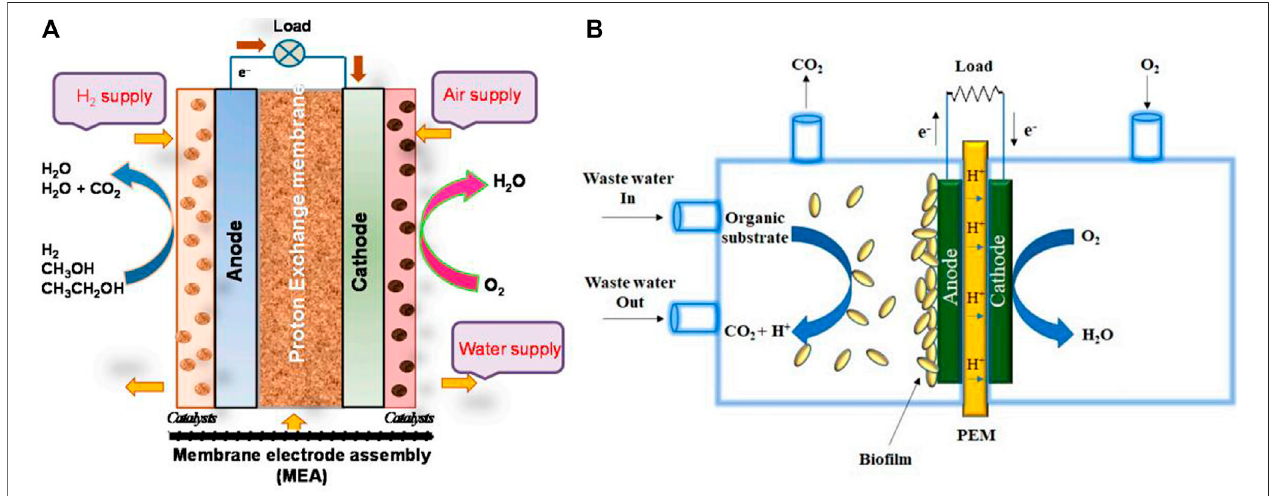
FIGURE 9 | The working principle of (A) direct alcohol fuel cells and (B) microbial fuel cells is depicted schematically (Ghosh et al., 2020).